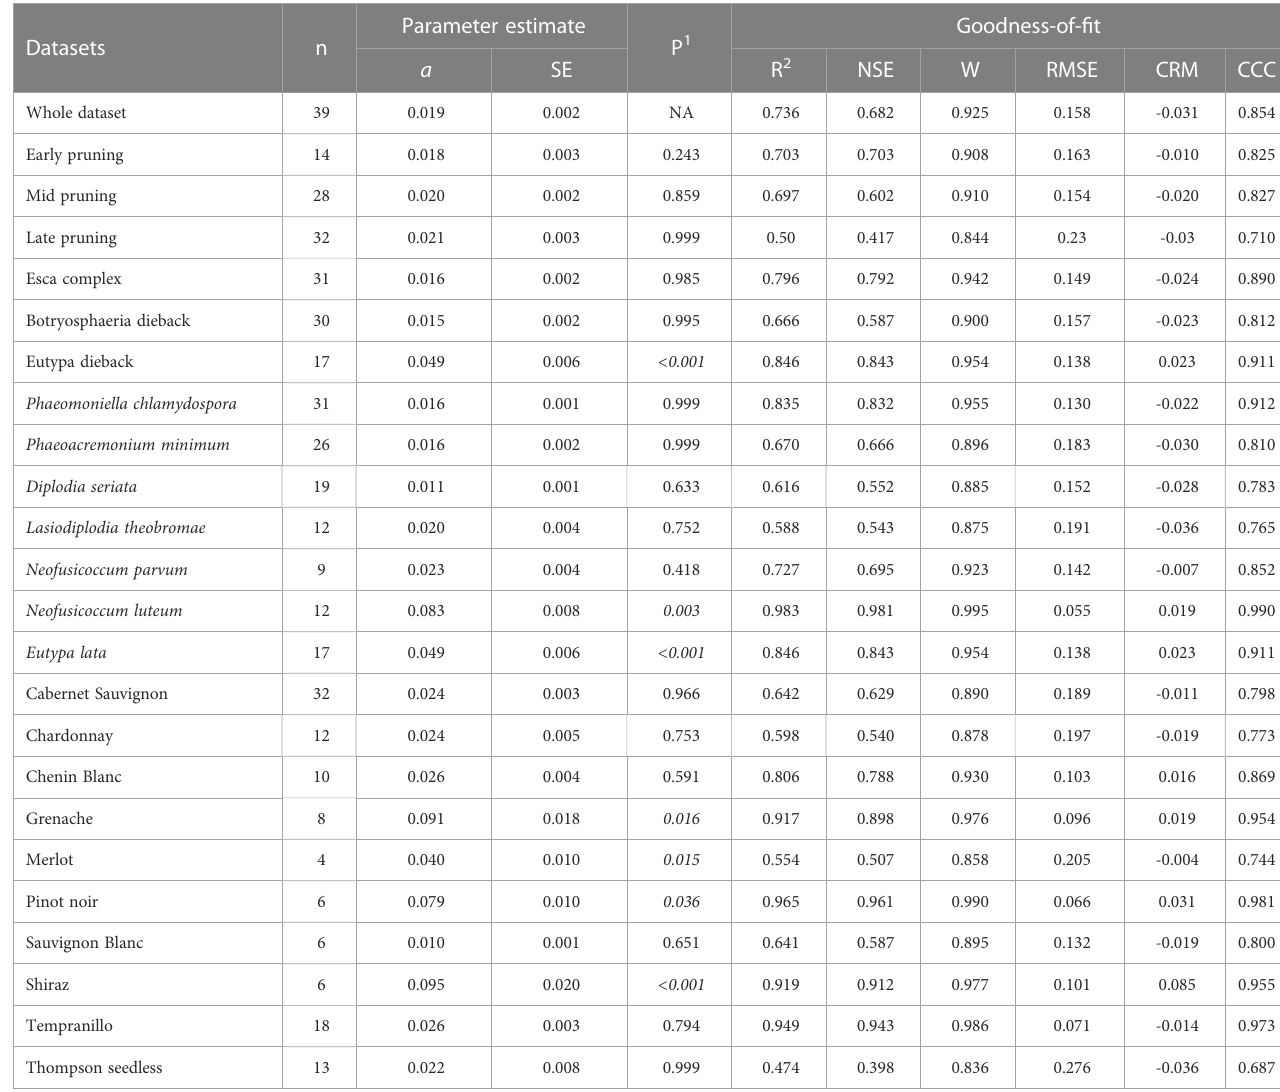
TABLE 2 Parameters and statistics of goodness-of- fi t for equation [1] (see text), which predicts pruning wound susceptibility as a function of time after pruning when wounds were inoculated, for the whole dataset obtained from the studies in Table 1 , and for subsets of data concerning different categories of the following main factors: pruning period, disease, species inoculated to wounds, and grape